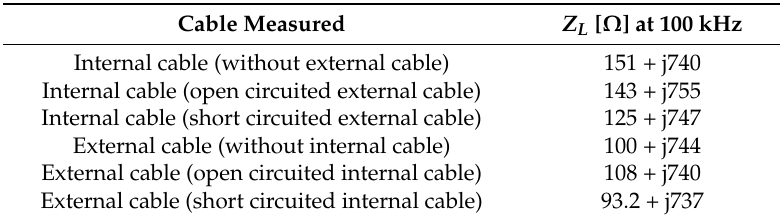
Table 2. Measured values of Impedance of 400m wires